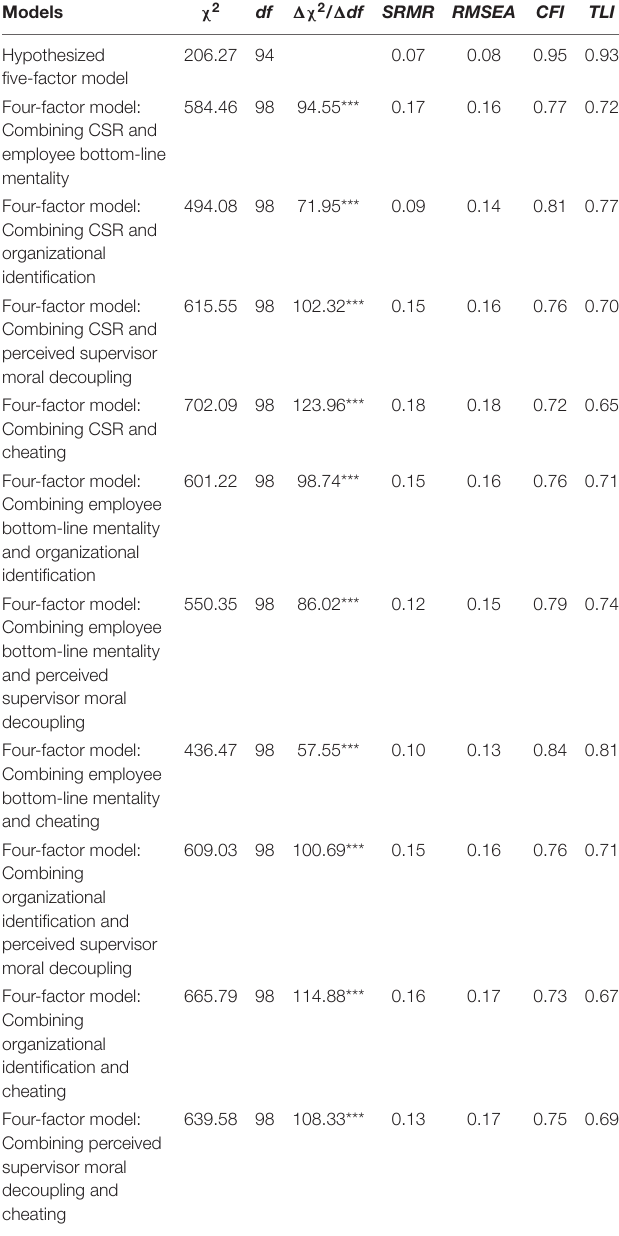
TABLE 1 | Model fit results for confirmative factor